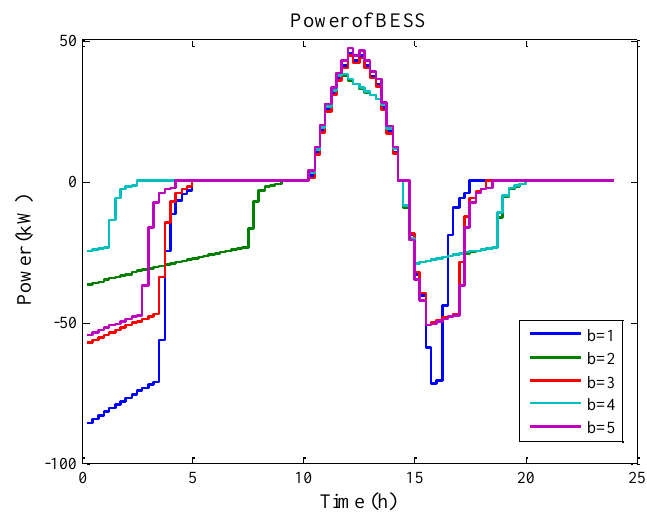
Figure 26. Battery power time series (Case study 3).